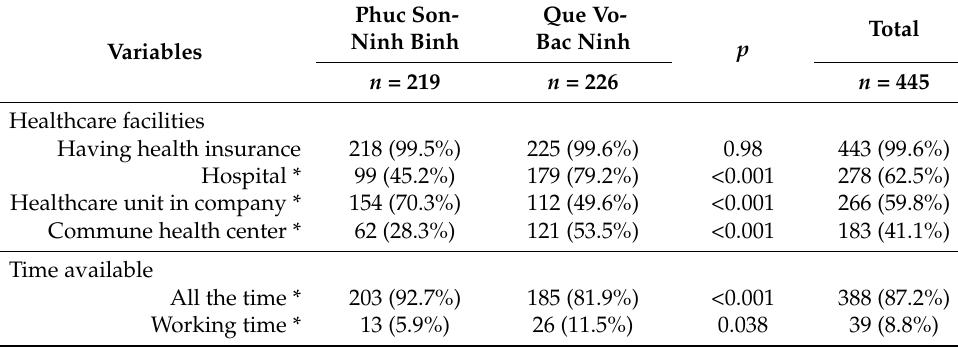
Table 6. Health care support to migrant workers during